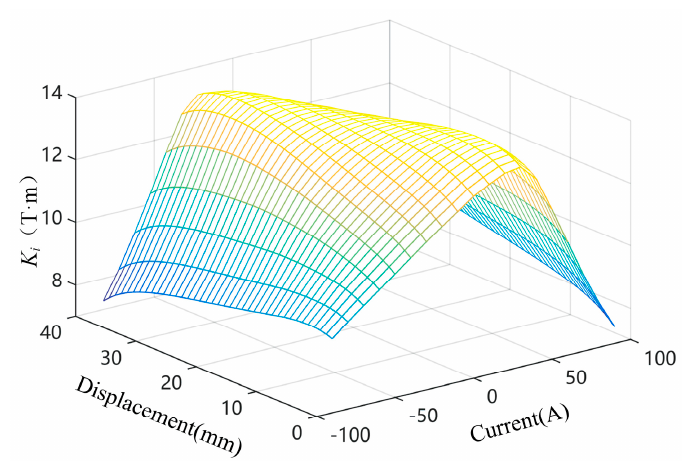
Figure 5. Thrust constant map of the LEM.